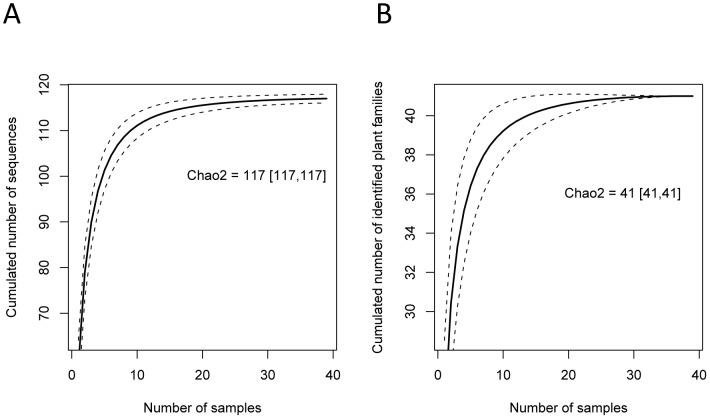
Accumulation curves of plant richness in the sampled tapir dung piles using the P6 loop marker.a) Cumulated richness of the plant DNA sequences (P6 loop), b) Cumulated richness of the identified plant families.